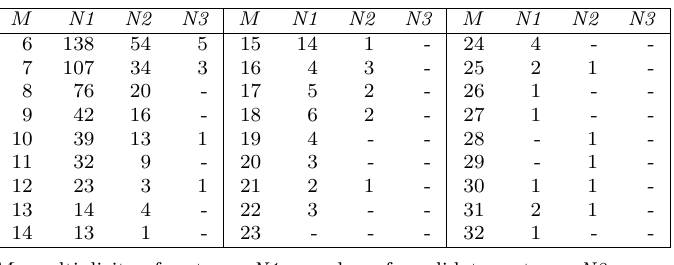
Fig. 2. Observational distribution of stellar systems on multiplicity M . The gray contour represents all systems. Gray bars represent all systems except optical pairs. The black contour represents all systems except optical pairs, but with the addition of closer, photometrically unresolved components (see text for details). Systems of multiplicity higher than 32 are discussed at the beginning of Section 2 and are not shown here. Table 2. Statistics of multiple